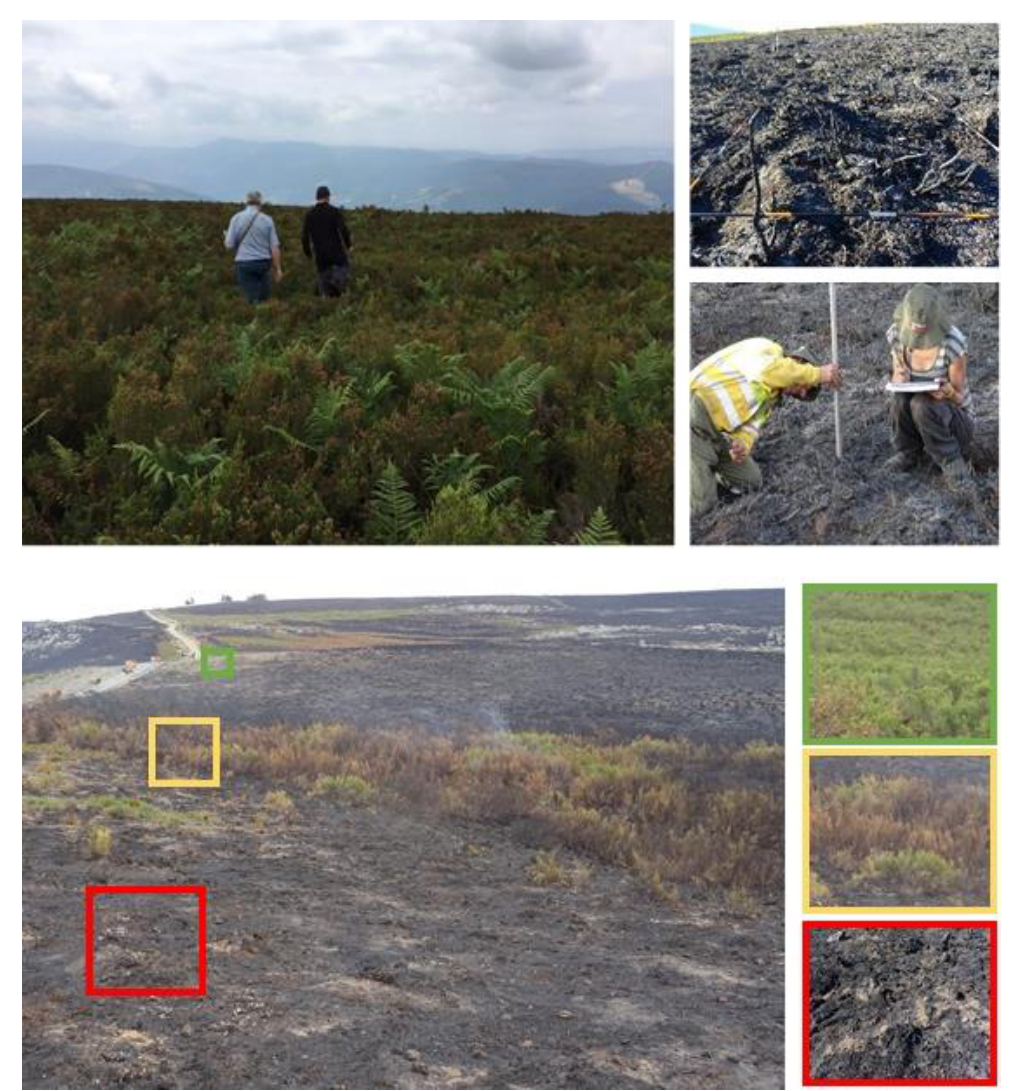
Figure 2. Upper: Study area before (left) and after the prescribed burn (right). Lower: Details of the three levels of burn severity: non-burned (green), moderate-low (yellow) and high (red). Next, the estimates of the probability density function are transferred to the next